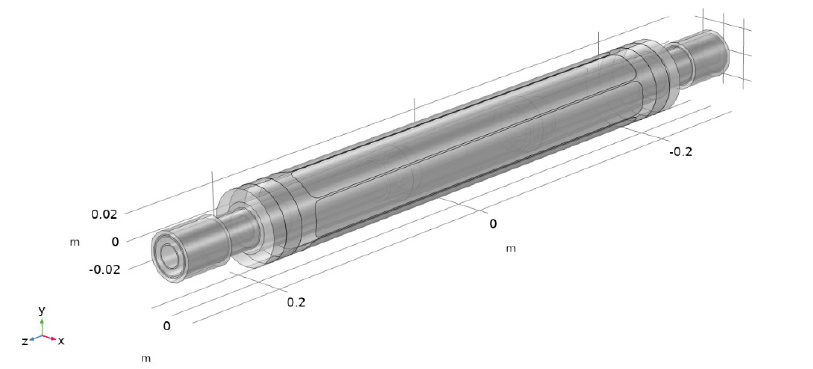
Figure 4. Joint physical dimensions.